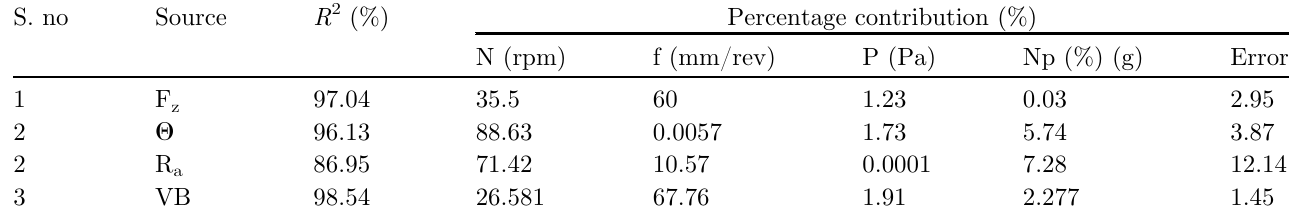
Table 7. Percentage contribution for the